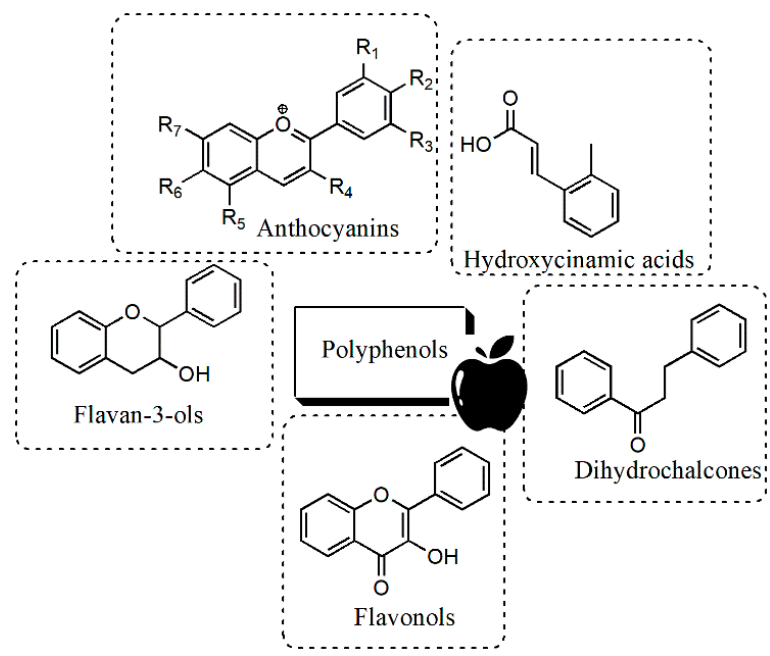
Figure 2 . Main classes of polyphenols occurring in apples. Figure 2. Main classes of polyphenols occurring in